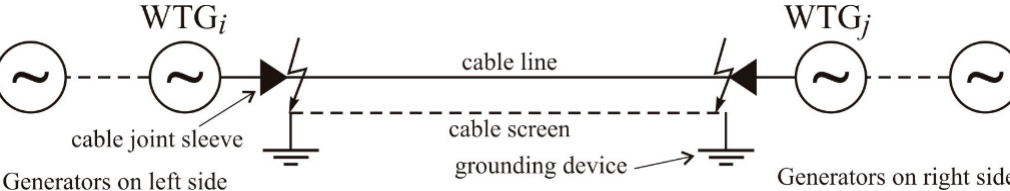
Figure 2. Schematic single-line diagram from some section of the cable line, which connects two WTGs in a group.